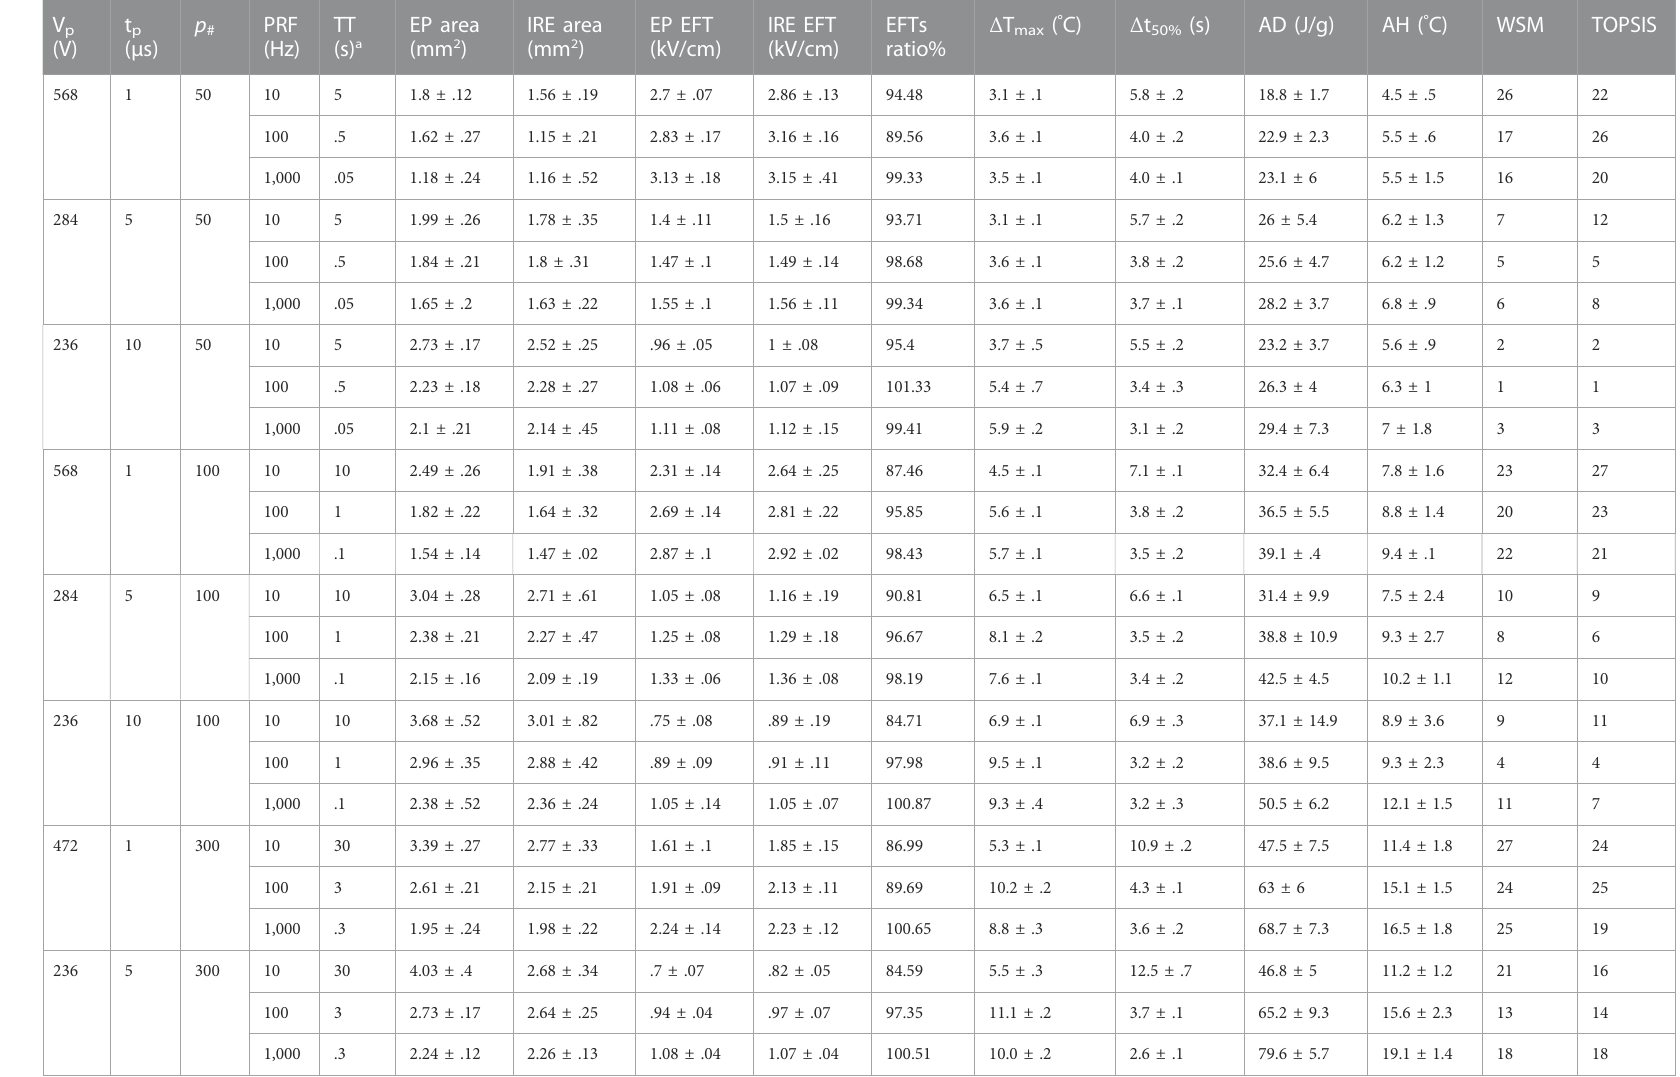
TABLE1Summarytablereportingpulsedelectric fi eldtreatmentendpointsfortherangeofPEFparametersinvestigatedinhumaninducedpluripotentstemcell-derivedcardiomyocytes.ForallcombinationsofPEF parameters tested, we reported the total treatment time (TT), electroporation (EP) and cell death (IRE) areas and EFTs, the EFTs ratio electroporation/cell death %, the measured maximum temperature change ( Δ